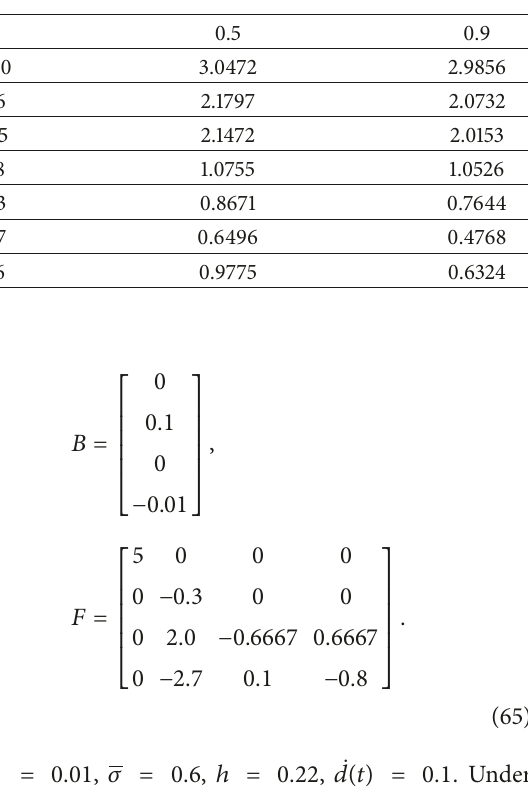
Table 1: Delay upper bound 𝑑 2 for different